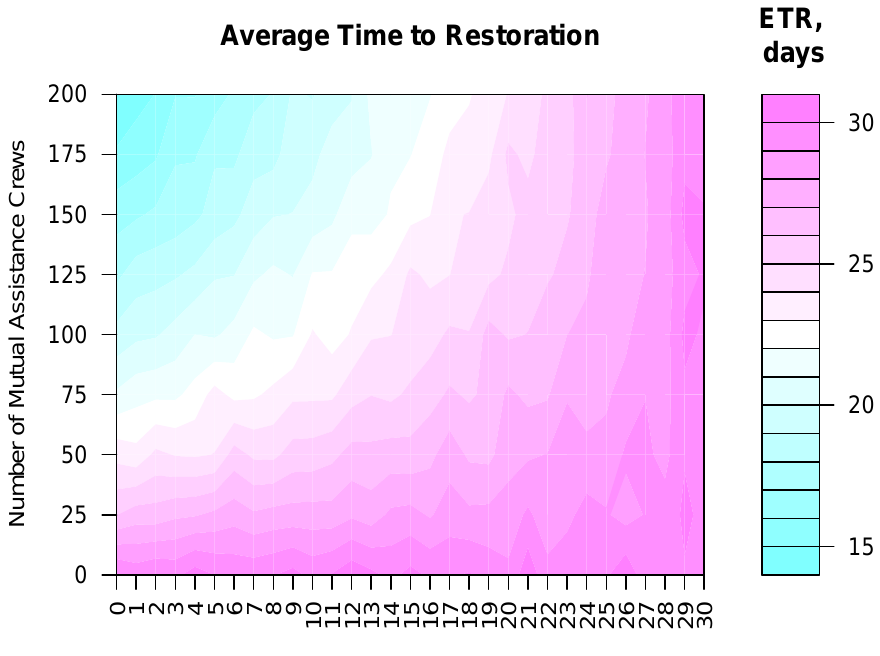
Figure 14. Changing number of mutual assistance crews and time to arrival for 15,000 outages. Crew start location set to area work center and search strategy set to nearest outage. Travel speed set to 25 mph. 85% crews working during day shift, 99% working during evening shift and 66%